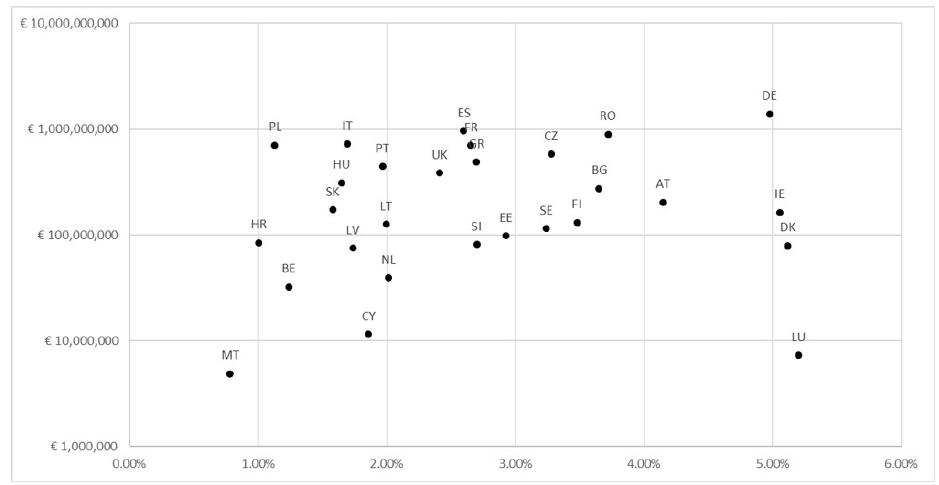
Figure 7. Total CLLD funding (EUR) vs. CLLD share of eligible ESI funding by country, 2014–2020 [7]. Note—a logarithmic scale is used on the